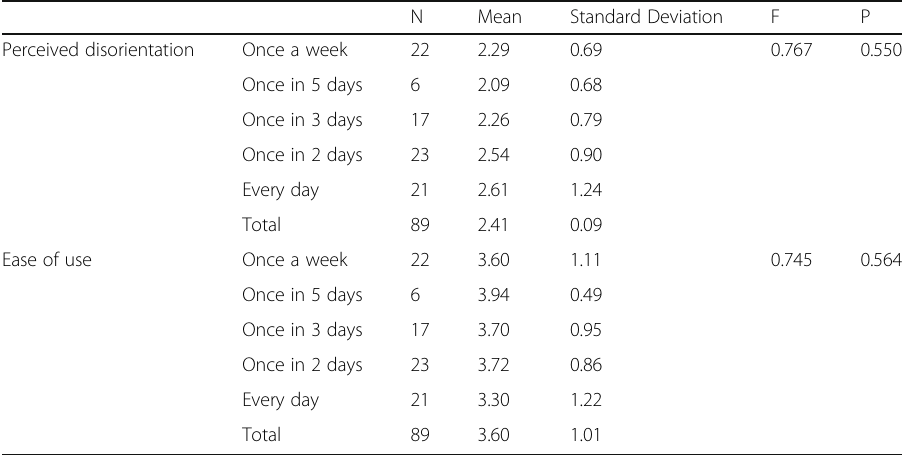
Table 9 ANOVA results for effect of frequency of studying using internet to perceived disorientation N Mean Standard Deviation F P Perceived disorientation Once a week 22